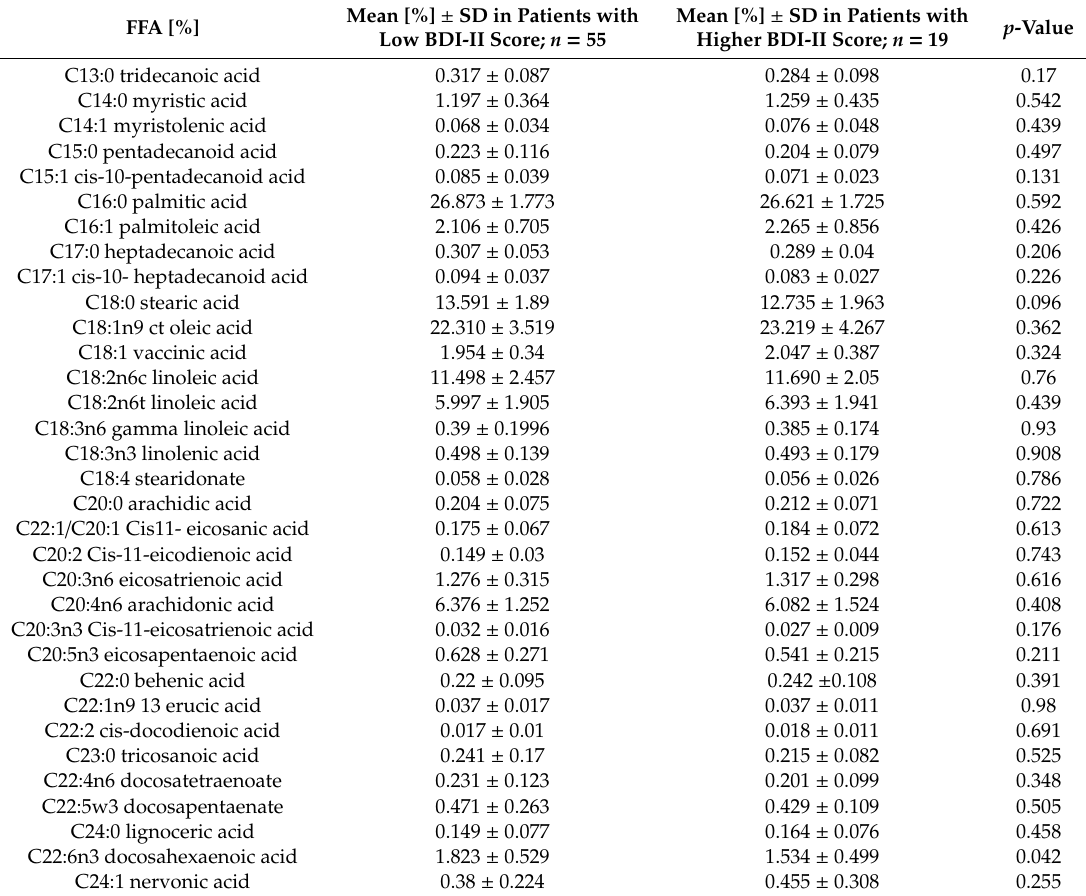
Table 5. The comparison of free fatty acids level between patients with low ( < 14) vs. higher ( > 13) BDI-II score. Mean [%] ± SD in Patients with Mean [%] ± SD in Patients with p FFA [%] Low BDI-II Score; n = 55 Higher BDI-II Score; n = 19